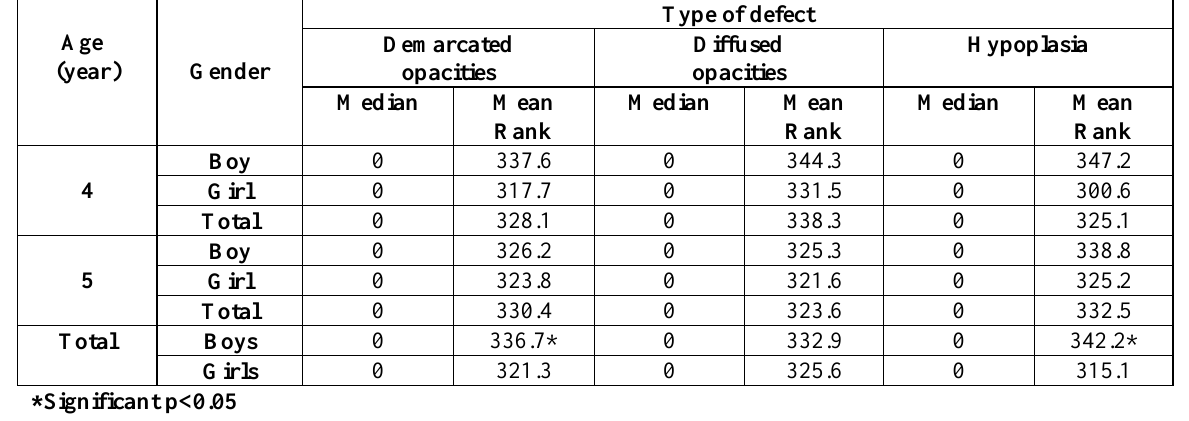
Table 5: Median and mean rank teeth with enamel anomalies by age and gender .